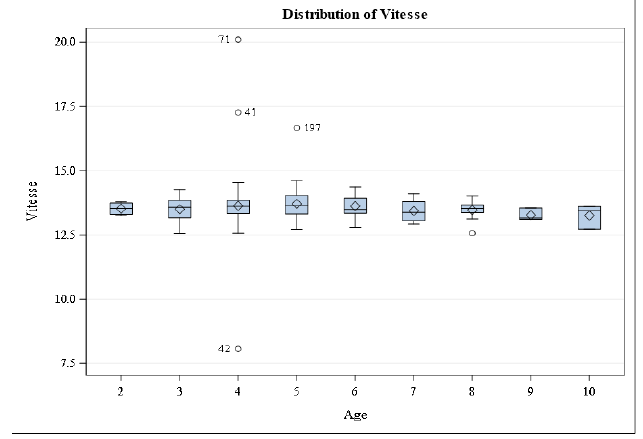
Figure 2: Age effect on horse